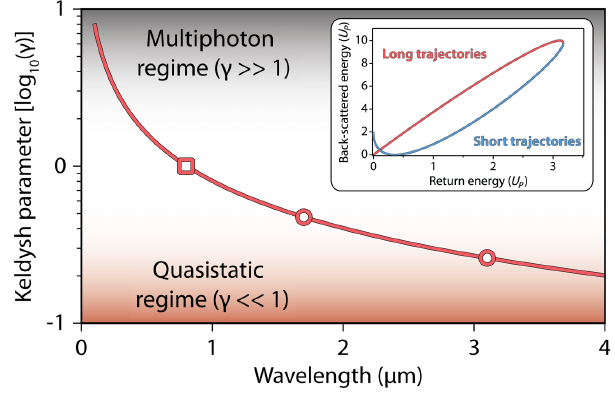
FIG. 1. Scaling of the Keldysh parameter versus driving wavelength for xenon atoms ionized with an intensity of 1 × 10 14 W cm − 2 . The regions of γ ≫ 1 and γ ≪ 1 are high- lighted by gray and red shading, respectively. The ubiquitous Ti: sapphire wavelength of 0 . 8 μ m (red square) and our OPCPA outputs (red circles) are presented. The inset shows the kinetic energy E of elastically backscattered electrons ( θ r ¼ 180 °) kin versus their return energy E r (for long and short trajectories) according to the semiclassical “ recollision model ” in units of the ponderomotive energy U P